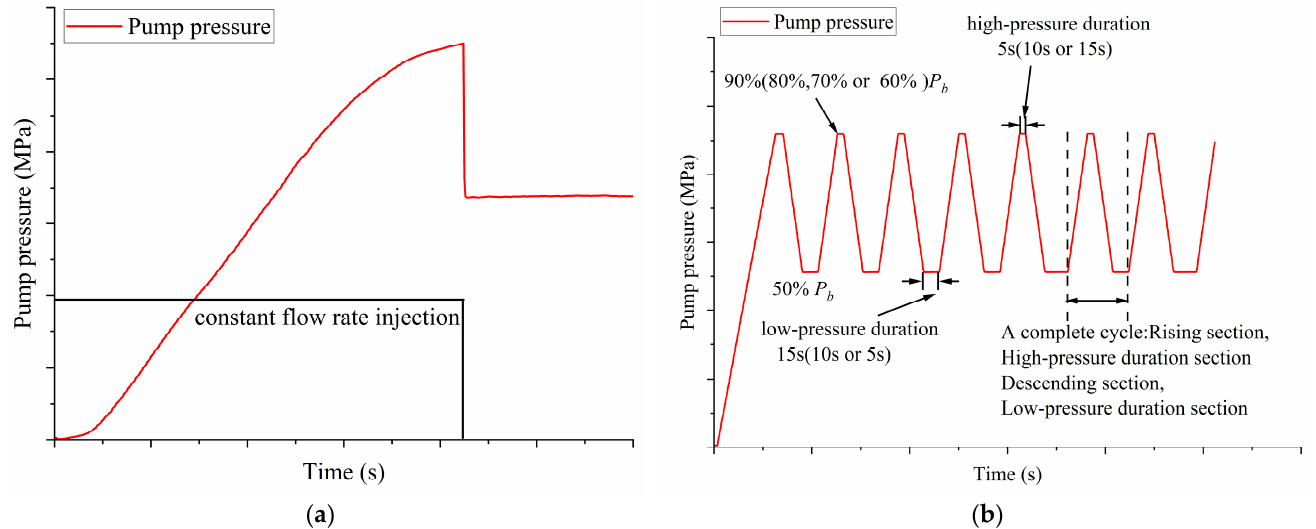
Figure 5. Schematic diagram of pump pressure curve: ( a ) conventional hydraulic fracturing, ( b ) cyclic hydraulic fracturing.